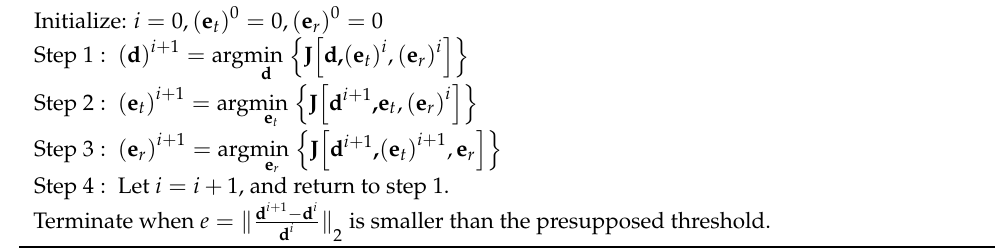
Algorithm 1 Compressed Sensing Imaging with Compensation of Motion Errors for MIMO